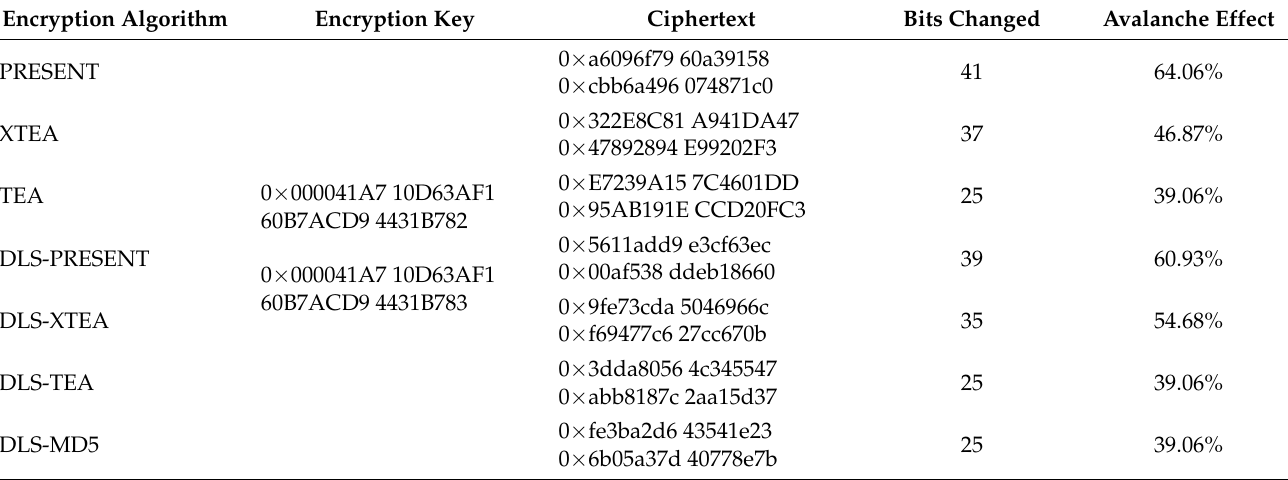
Table 4. Avalanche effect calculated when a one-bit change is made on a specific encryption